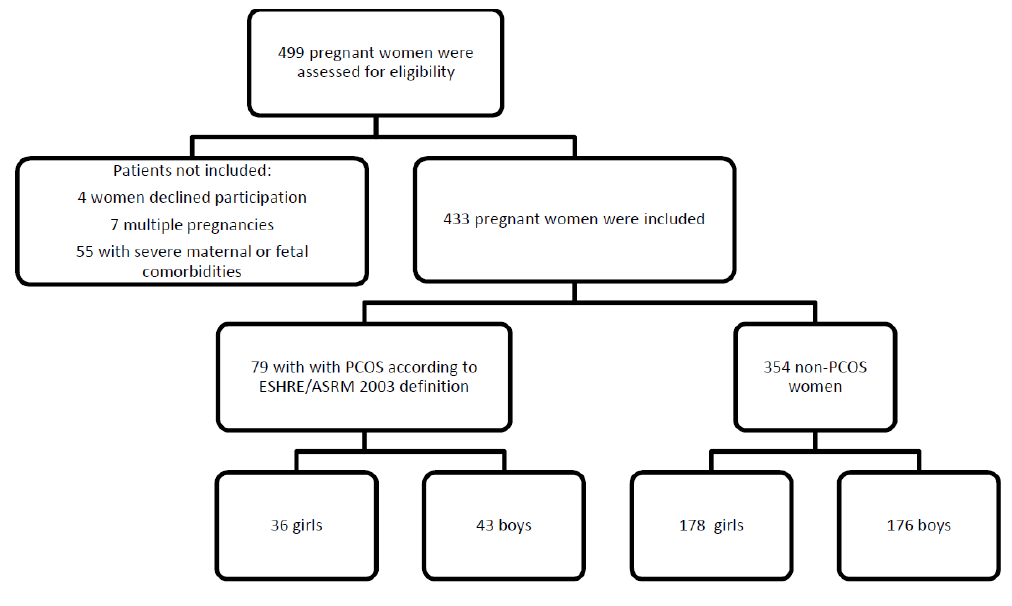
Figure 1. Flow chart presenting the study population and distribution. PCOS: polycystic ovary syndrome.